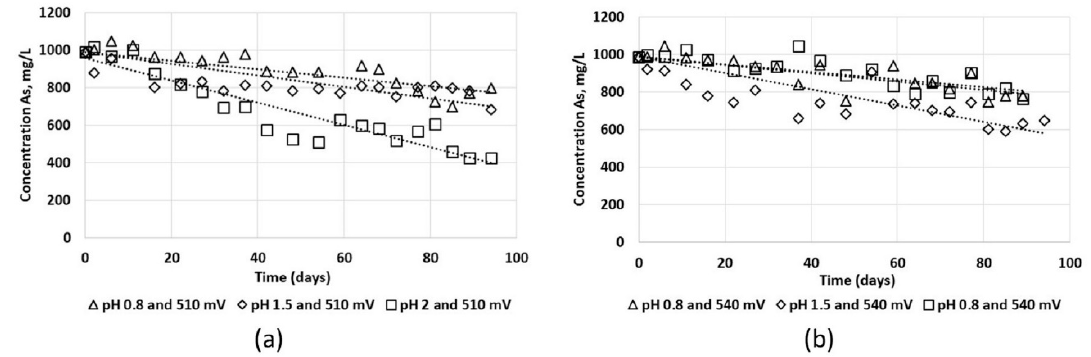
Figure 3. Arsenic concentration behavior in solution over time. ( a ) C-1, C-2, C-3, ( b ) C-4, C-5, C-6.